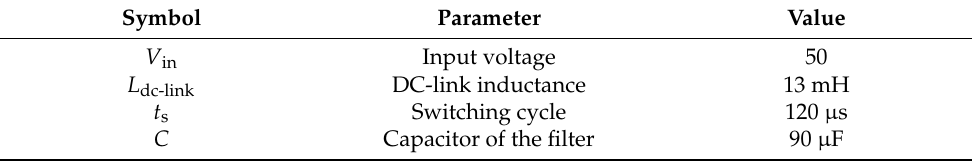
Table 2. Parameters of the five-phase dual-rotor